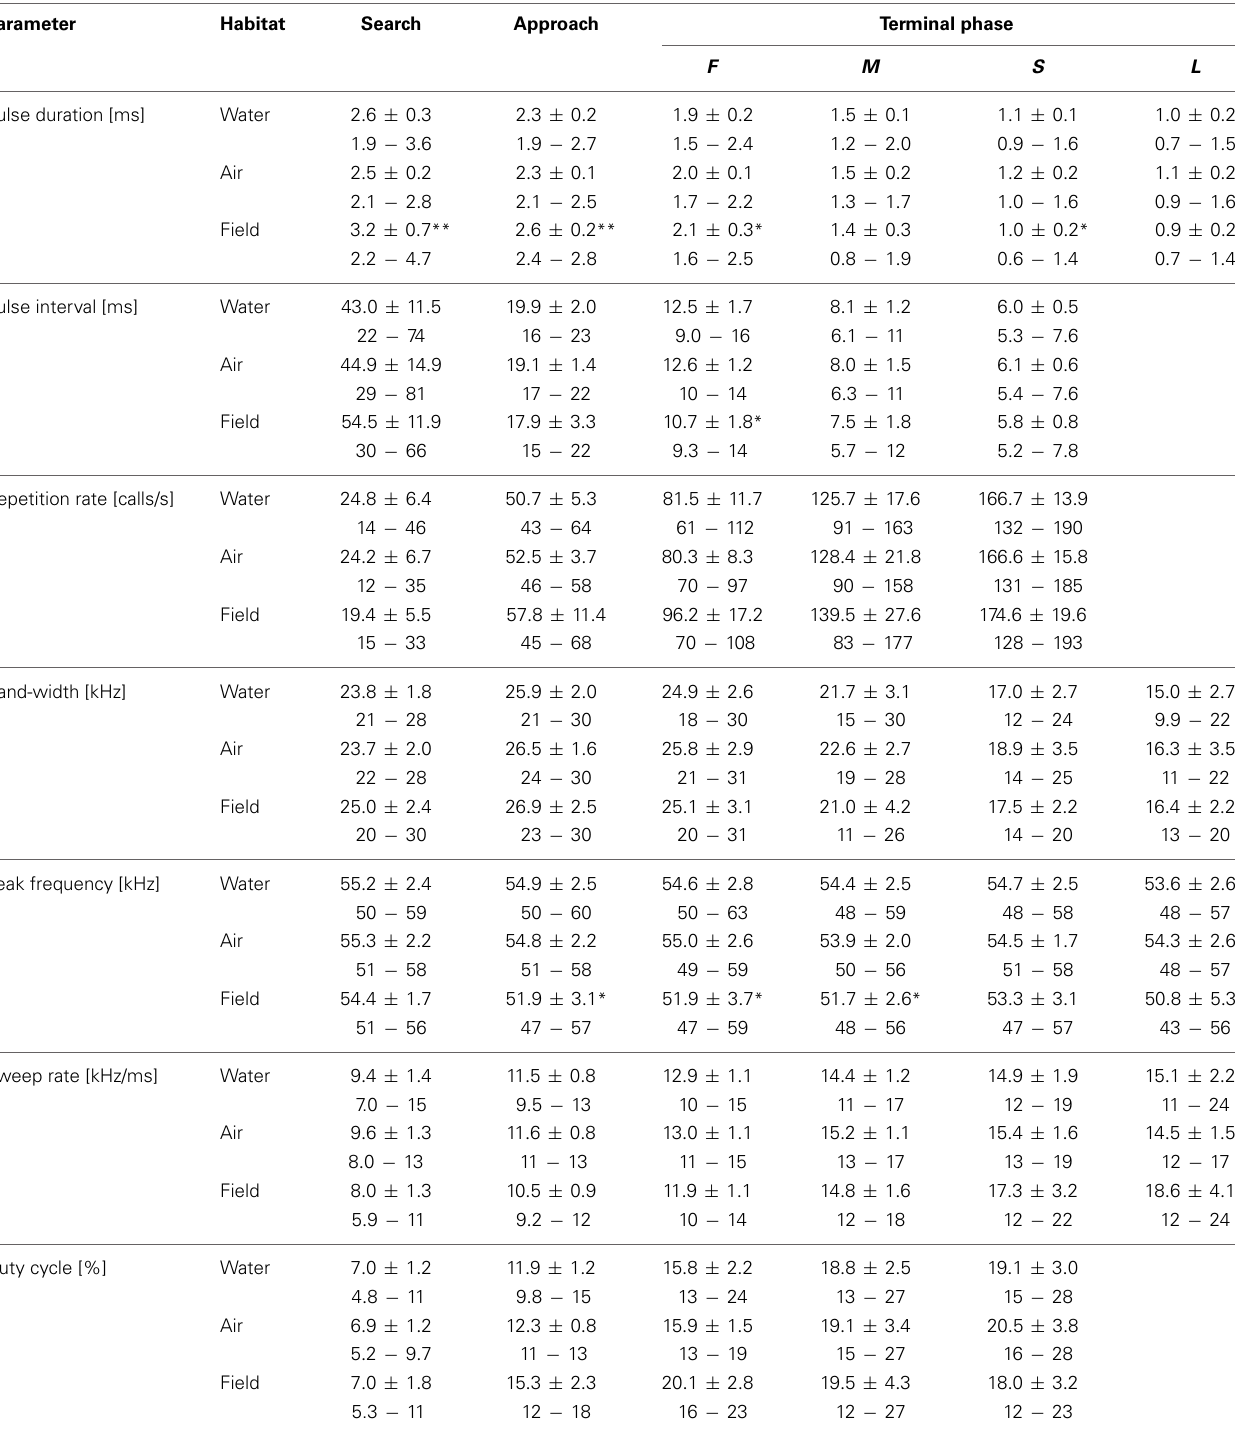
Table 1 | Seven echolocation parameters of M. macrophyllum foraging in the flight cage and in the field at BCI, Panamá.